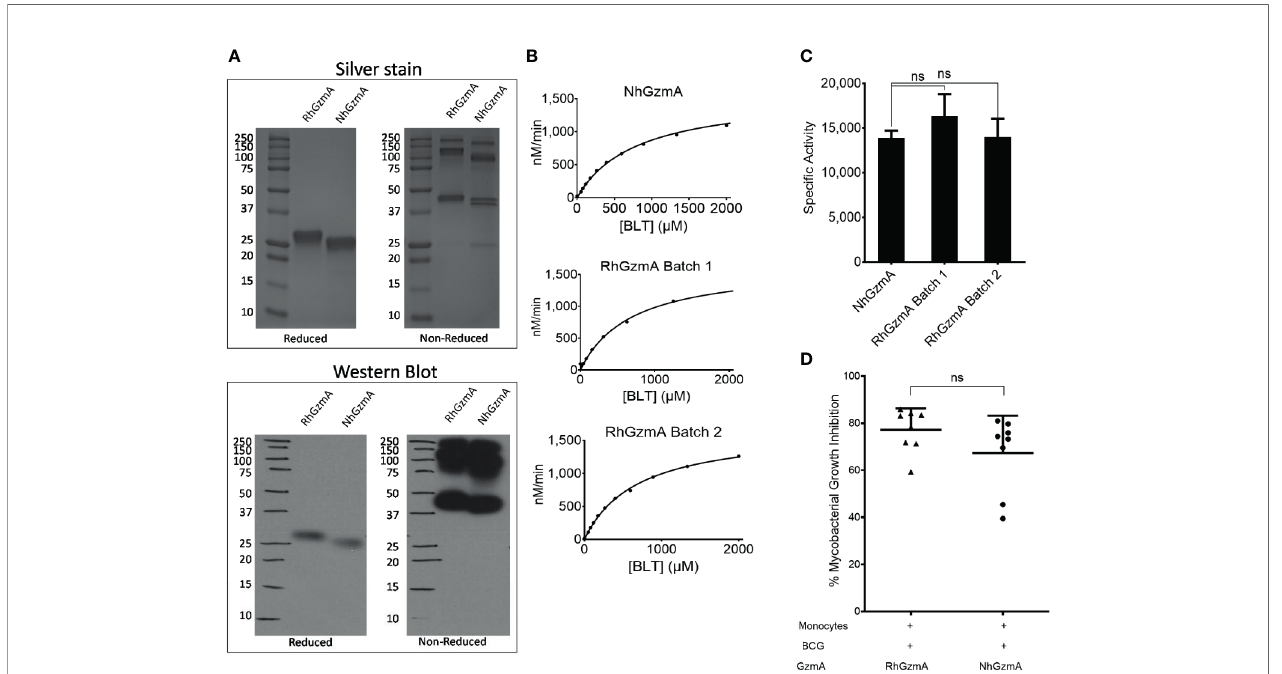
FIGURE 1 | Recombinant human GzmA phenocopies native protein. (A) RhGzmA and NhGzmA homodimerize (~50 kDa, some monomer at ~25 kDa in NhGzmA) and are pure as shown by silver stain (top fi gure) and western blot (bottom fi gure). Under reducing conditions, GzmA assumes the monomer form, while under non- reducing conditions homodimer and polymers of GzmA are the predominant forms. RhGzmA has a His-tag at the C-terminus of the protein, which accounts for the slightly heavier MW. (B, C) RhGzmA and NhGzmA cleave BLT substrate at similar rates, and different lots of RhGzmA have similar enzymatic activity in the BLT esterase assay. Results are plotted using the Michaelis-Menten equation (B) and fi tted to produce speci fi c activity (C) . Commercially obtained native protein, and two different lots of puri fi ed recombinant protein are shown. Negative control results (BLT alone) were subtracted from results for each experiment (unpaired t-test, experiment repeated at least three times). (D) Recombinant human GzmA recapitulates mycobacterial growth inhibition as native protein measured in the Mycobacterial Growth Inhibition Assay (n=8; data representative of two independent experiments; means and SEM; Wilcoxon matched-pairs signed rank test) (*p < 0.05, **p < 0.01, ***p < 0.001; ns, not signi fi